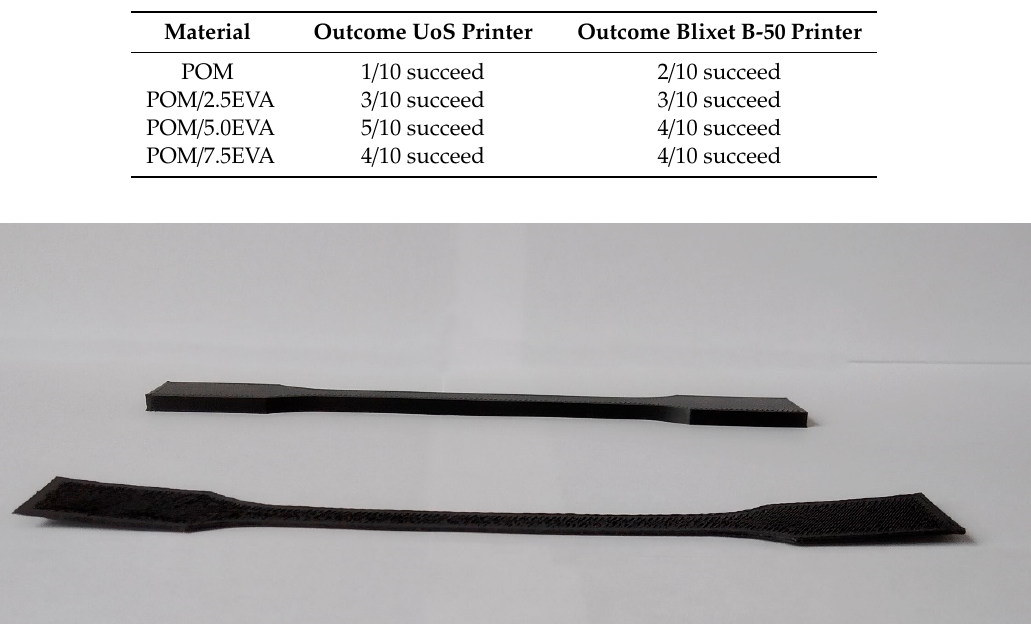
Table 9. The number of defects detected for analyzed samples.